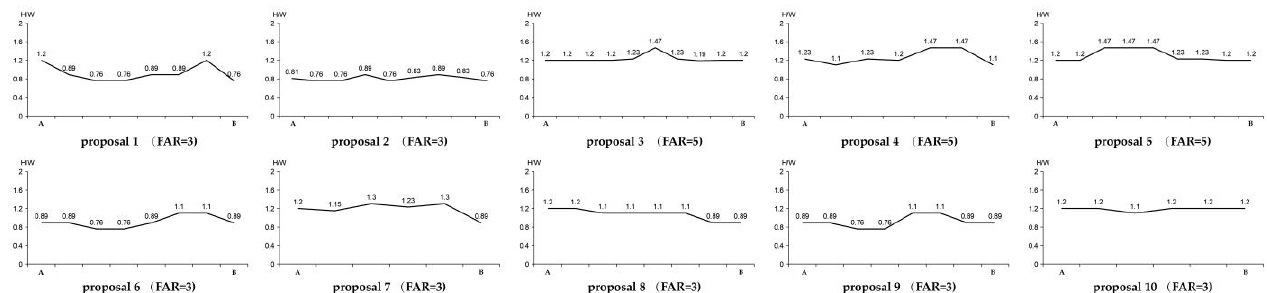
Figure 11. Height-to-street width ratios of buildings in 10 representative urban design proposals (The x-axis represents, from left to right, the height-to-width ratio of the buildings passing from point A to B).